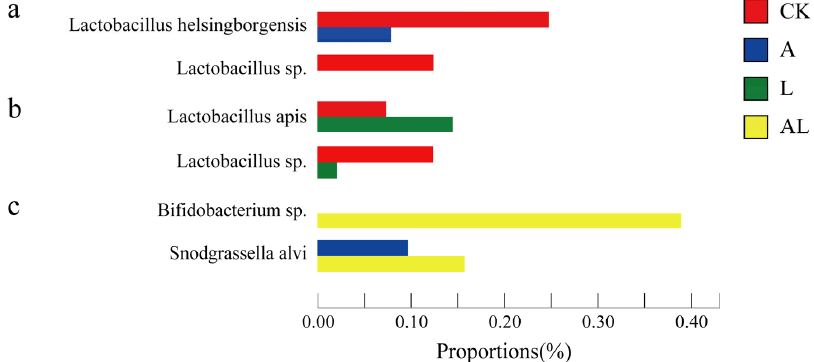
Figure 5. Significant differences in the bacteria in honeybees at the species levels. ( a ) Significant differences between species in the CK and A groups. ( b ) Significant differences between species in the CK and L groups. ( c ) Significant differences between species in the A and AL groups. Each bar represents the relative abundance of each species.